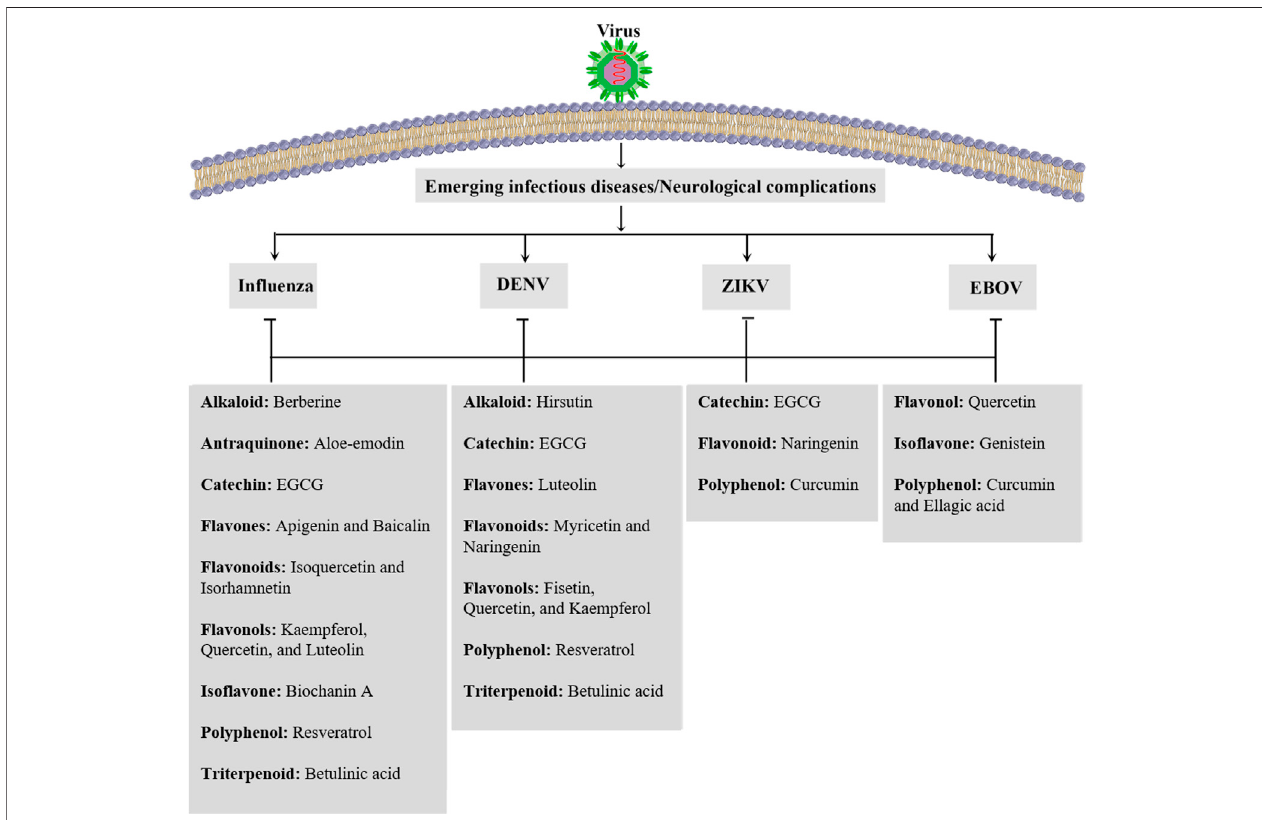
FIGURE 5 | Candidate phytochemicals in combating neurological signs of emerging infectious diseases. DENV: dengue virus, EBOV: Ebola virus, EGCG: epigallocatechin gallate, and ZIKV: Zika virus.